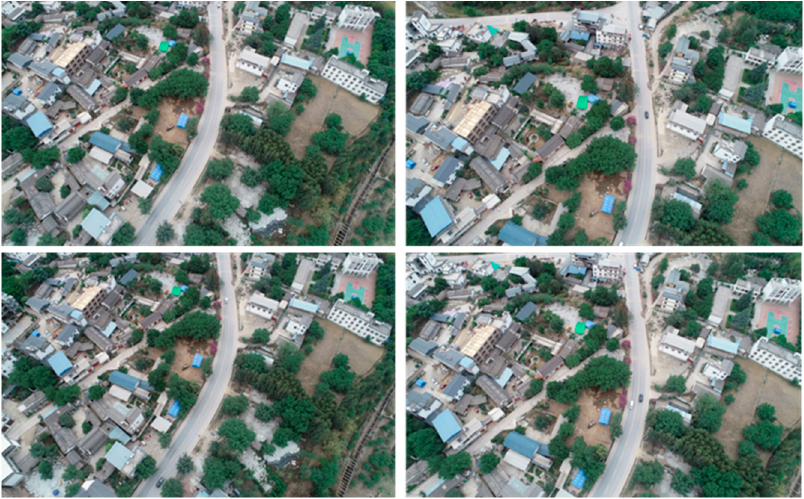
Figure 1. Multi-view UAV images of the earthquake area.